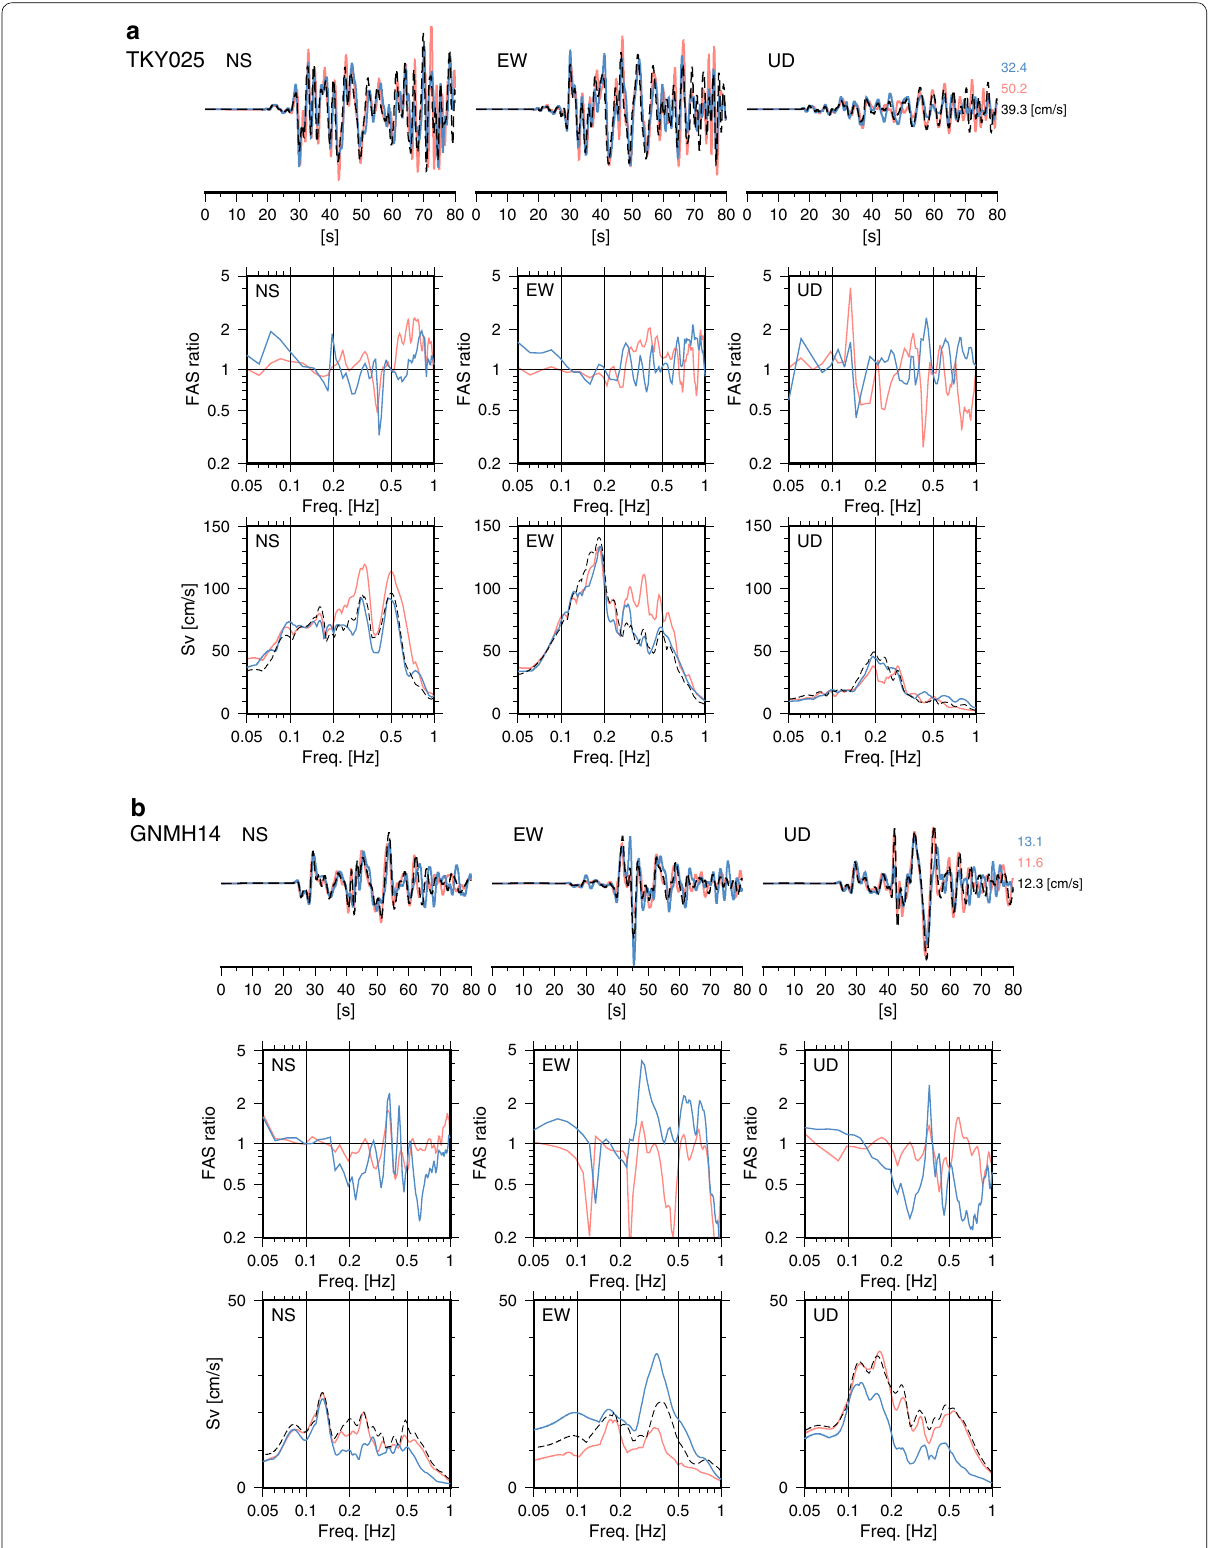
Fig. 4 Simulated ground motion at selected stations. Same as Fig. 3 but for the source model